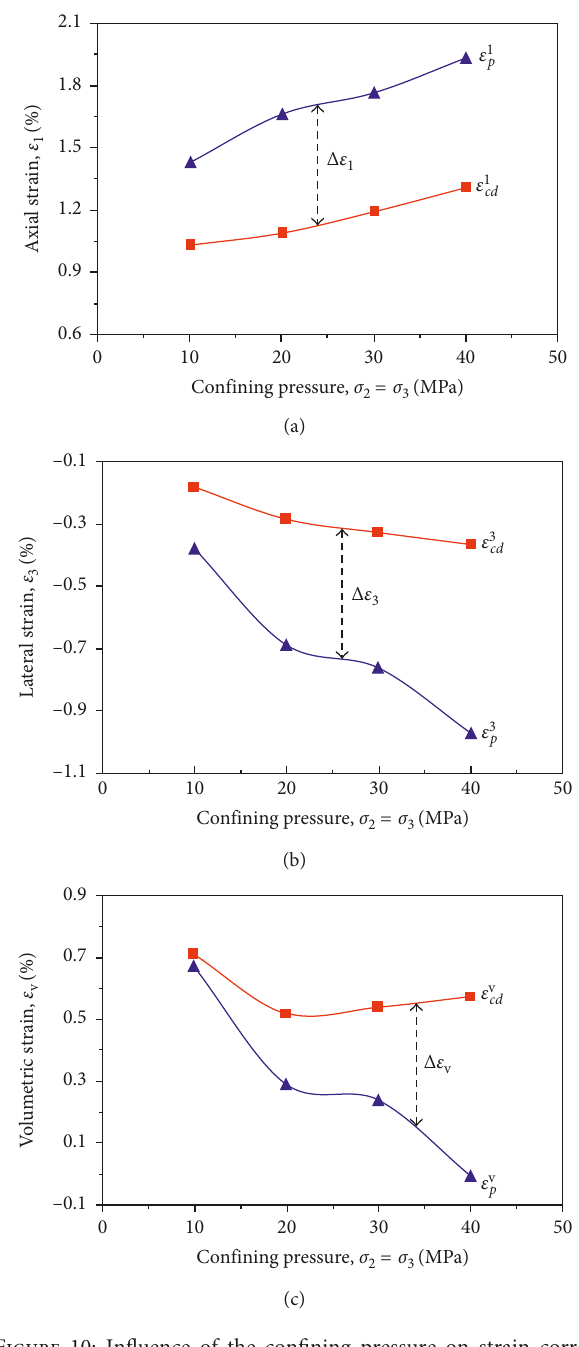
Figure 10: Influence of the confining pressure on strain corre- sponding to each characteristic stress under conventional triaxial compression experiments: (a) axial strain; (b) lateral strain; (c) volumetric strain.